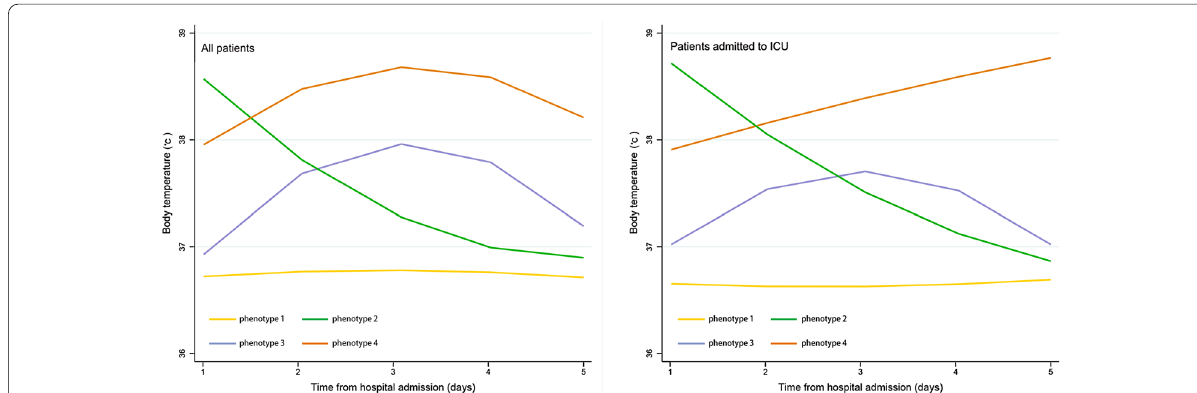
Fig. 1 Temperature-trajectory phenotypes in COVID-19 patients. Phenotype 1 (normothermic: yellow line)—patients with normal body temperature; Phenotype 2 (fever, rapid defervescence: green line)—patients with fever on admission but rapid defervescence; Phenotype 3 (gradual fever onset: purple line)—patients had normal temperature on admission but had fever later; Phenotype 4 (fever, slow defervescence: